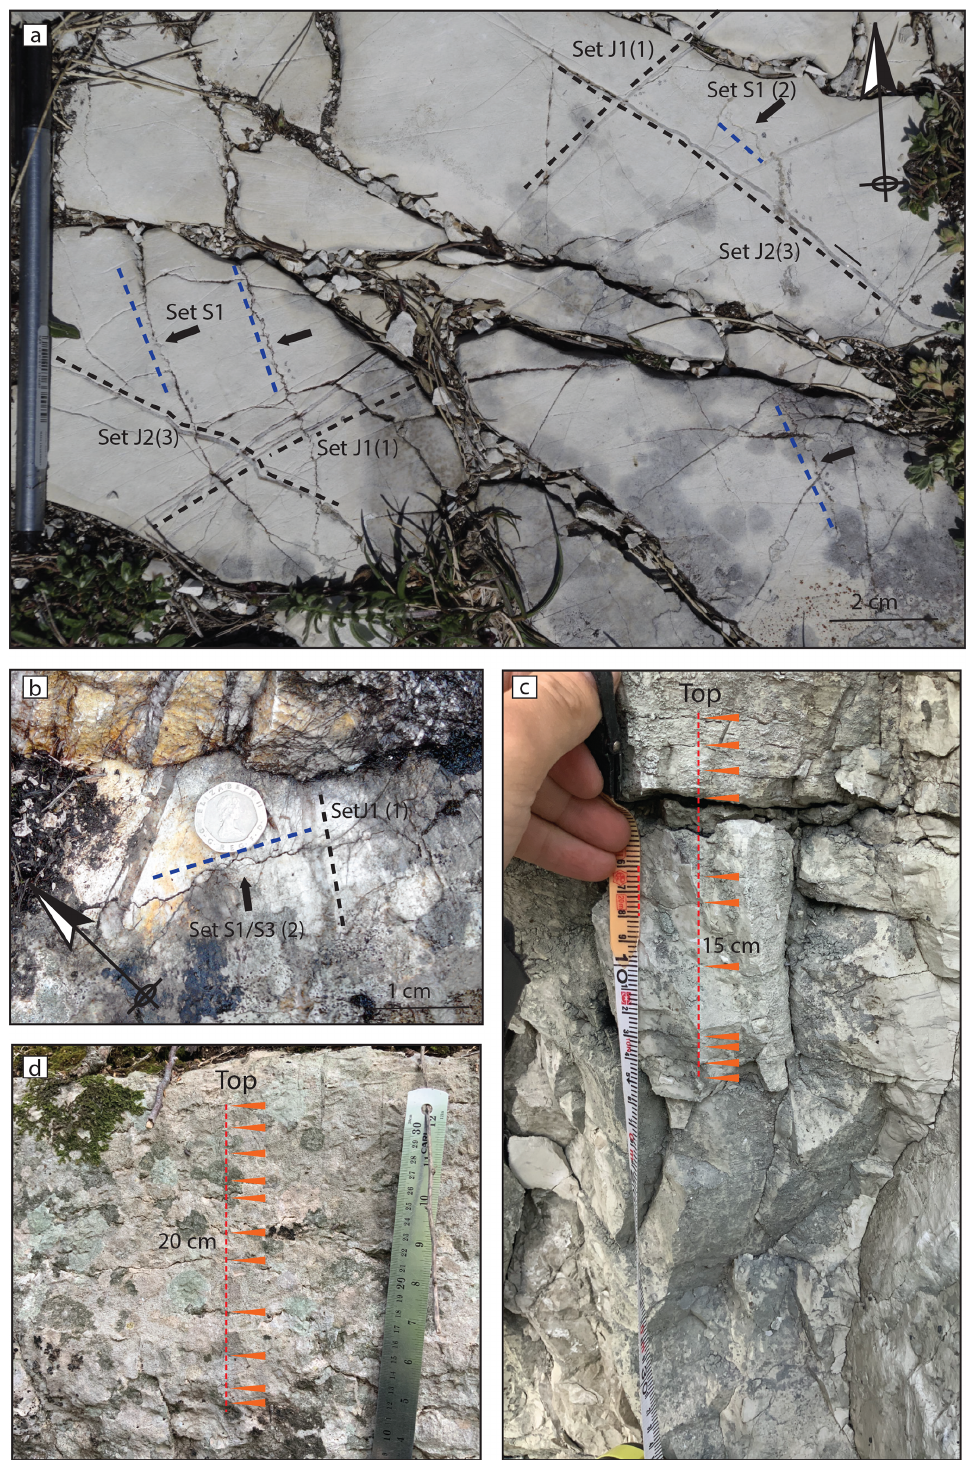
Figure 2. Field photographs showing chronological relationships between veins, joints, and stylolites. (a) Monte Nero and (b) Monte Cingoli sets are reported along with local chronological order between brackets, as deduced from crosscutting and abutment relationships displayed. Dotted lines depict the labelled fracture and tectonic stylolite orientation in black and blue, respectively. Bedding-parallel stylolites spacing from (c) the Maiolica Fm. (Monte Subasio) and (d) the Massiccio Fm. (Monte Cingoli). Intersections between bedding-parallel stylolites and scanline are pointed out with orange